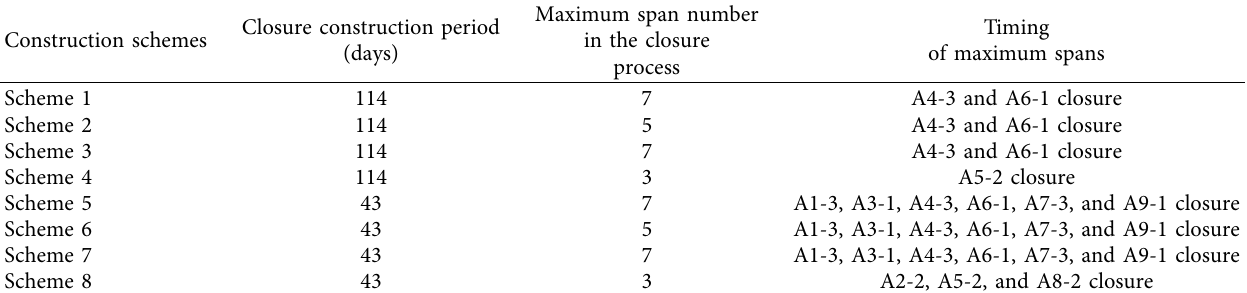
Table 1: Te closure scheme duration and the maximum span number in the closure process.